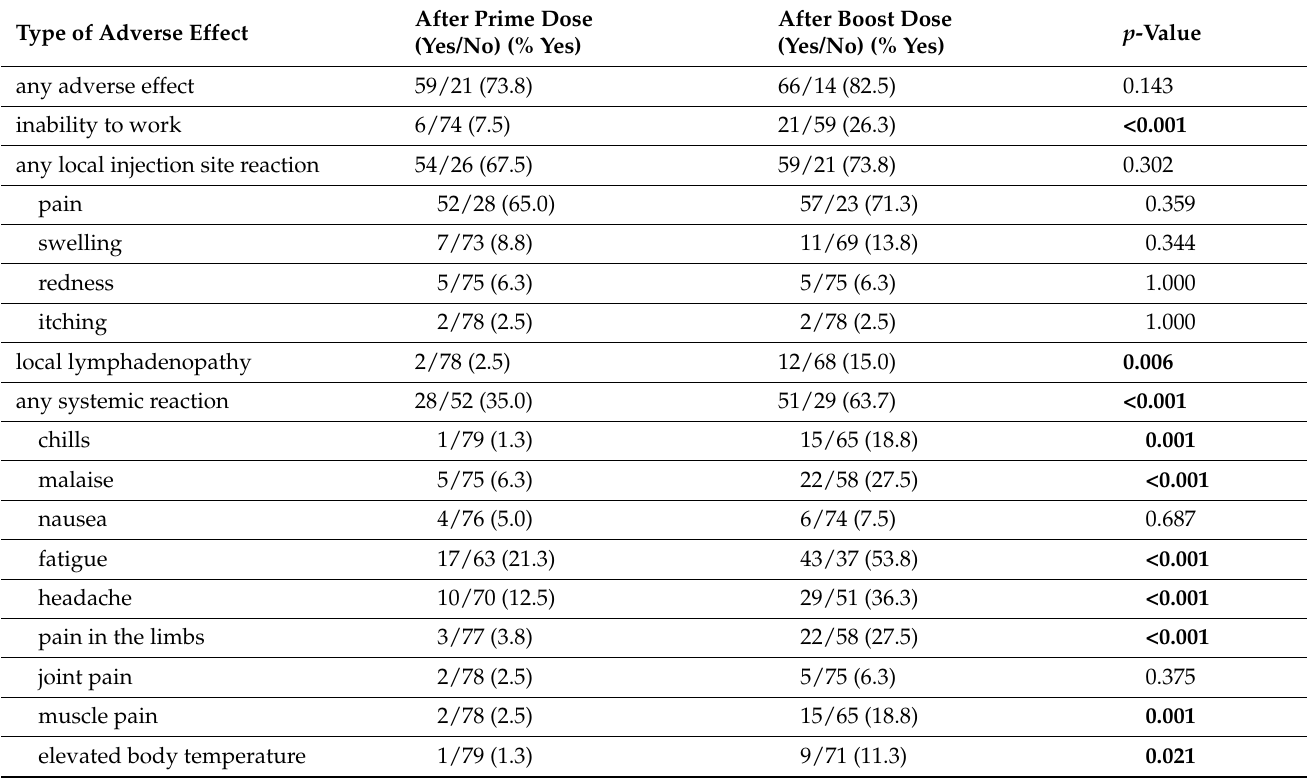
Table 1. Frequency of the adverse effects after the prime and boost